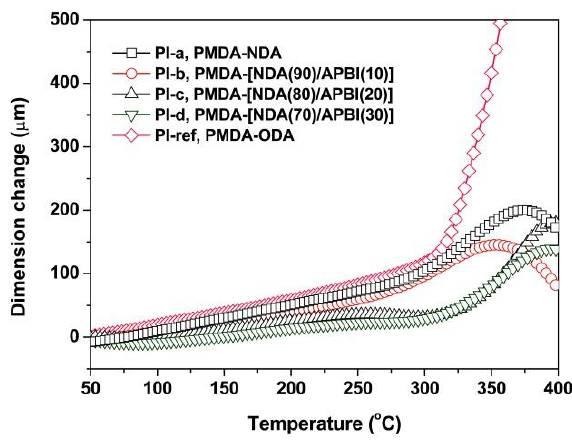
Figure 10. Thermomechanical analysis (TMA) curves of PI films.